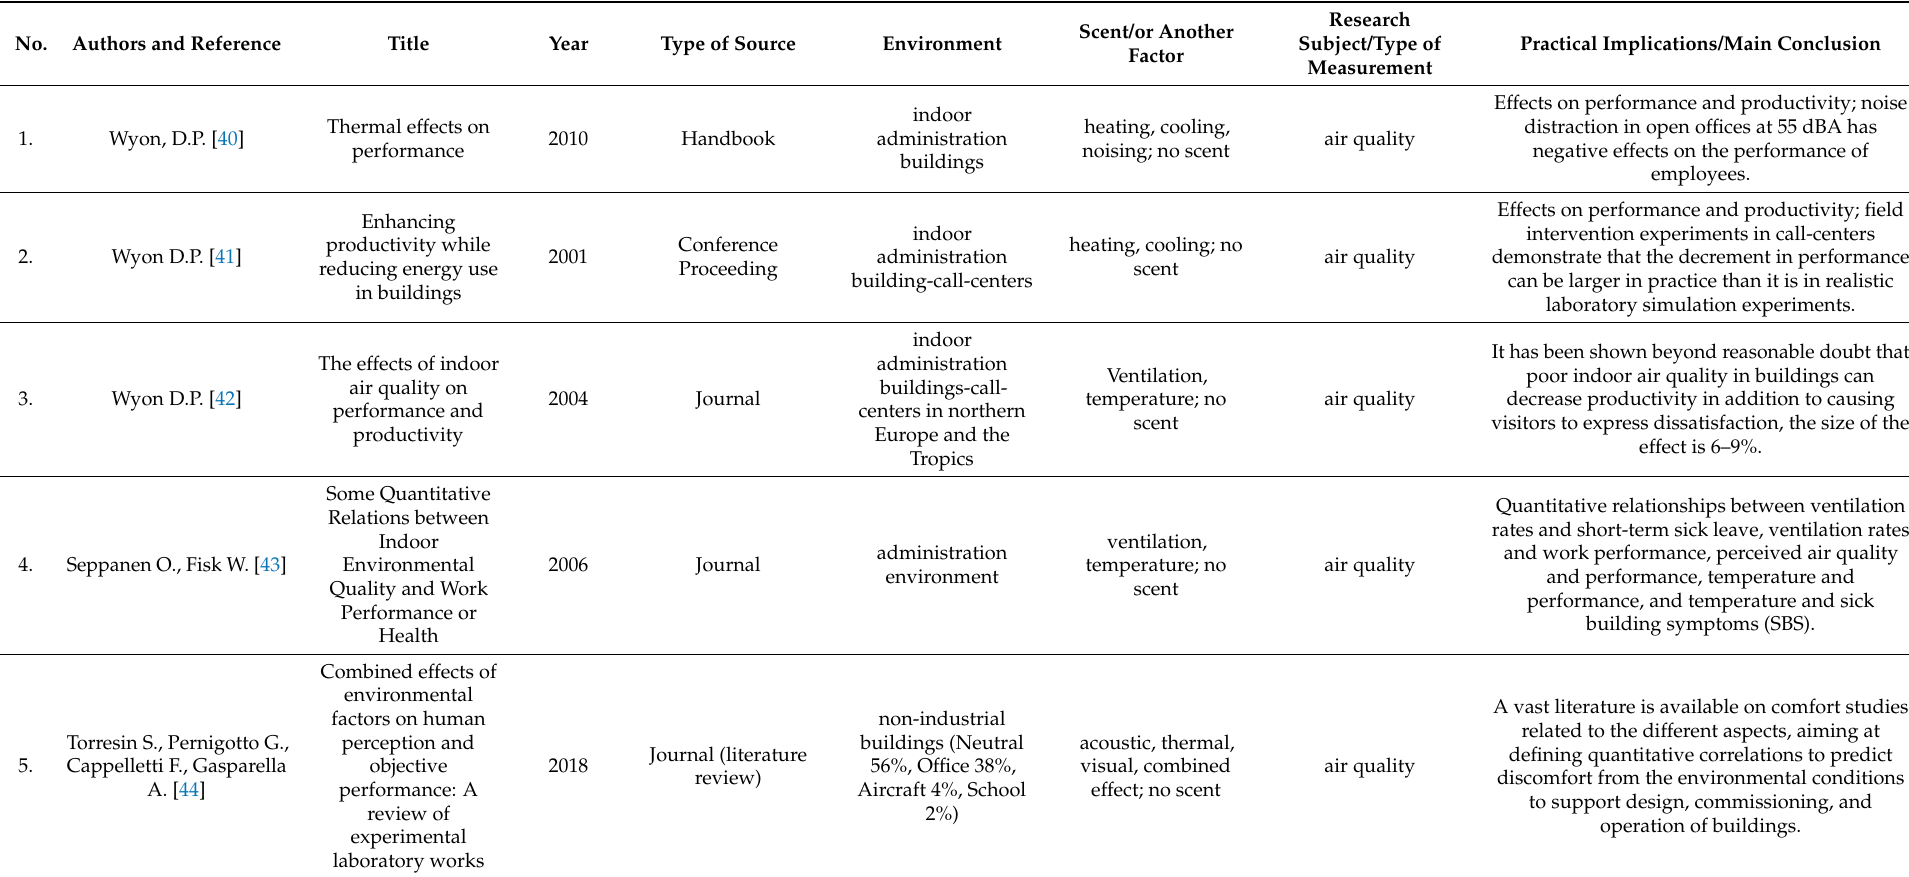
Table 2. Characteristics of the most relevant information